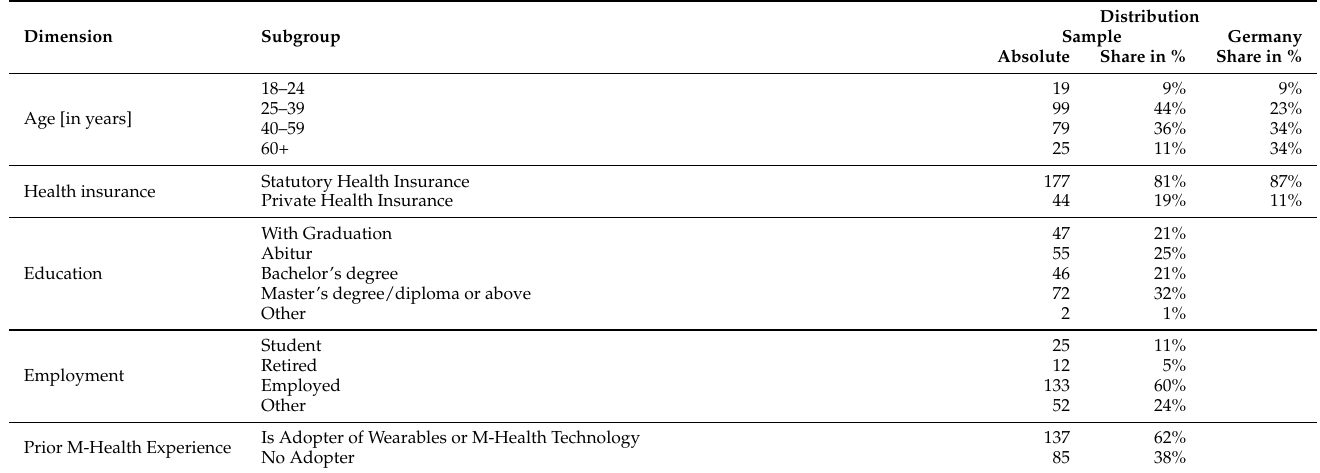
Table A6. Distribution of Sample and German